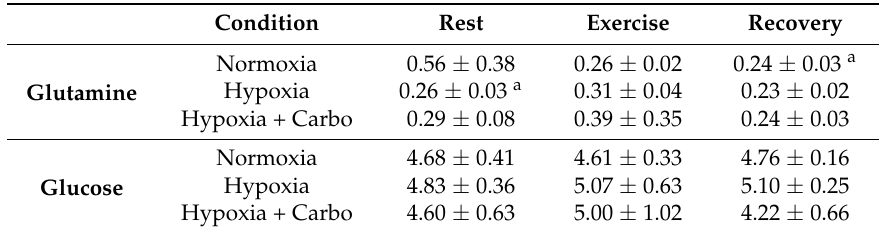
Table 5. Serum concentration of glutamine and glucose at rest, after exercise and after recovery in normoxia, hypoxia and hypoxia +